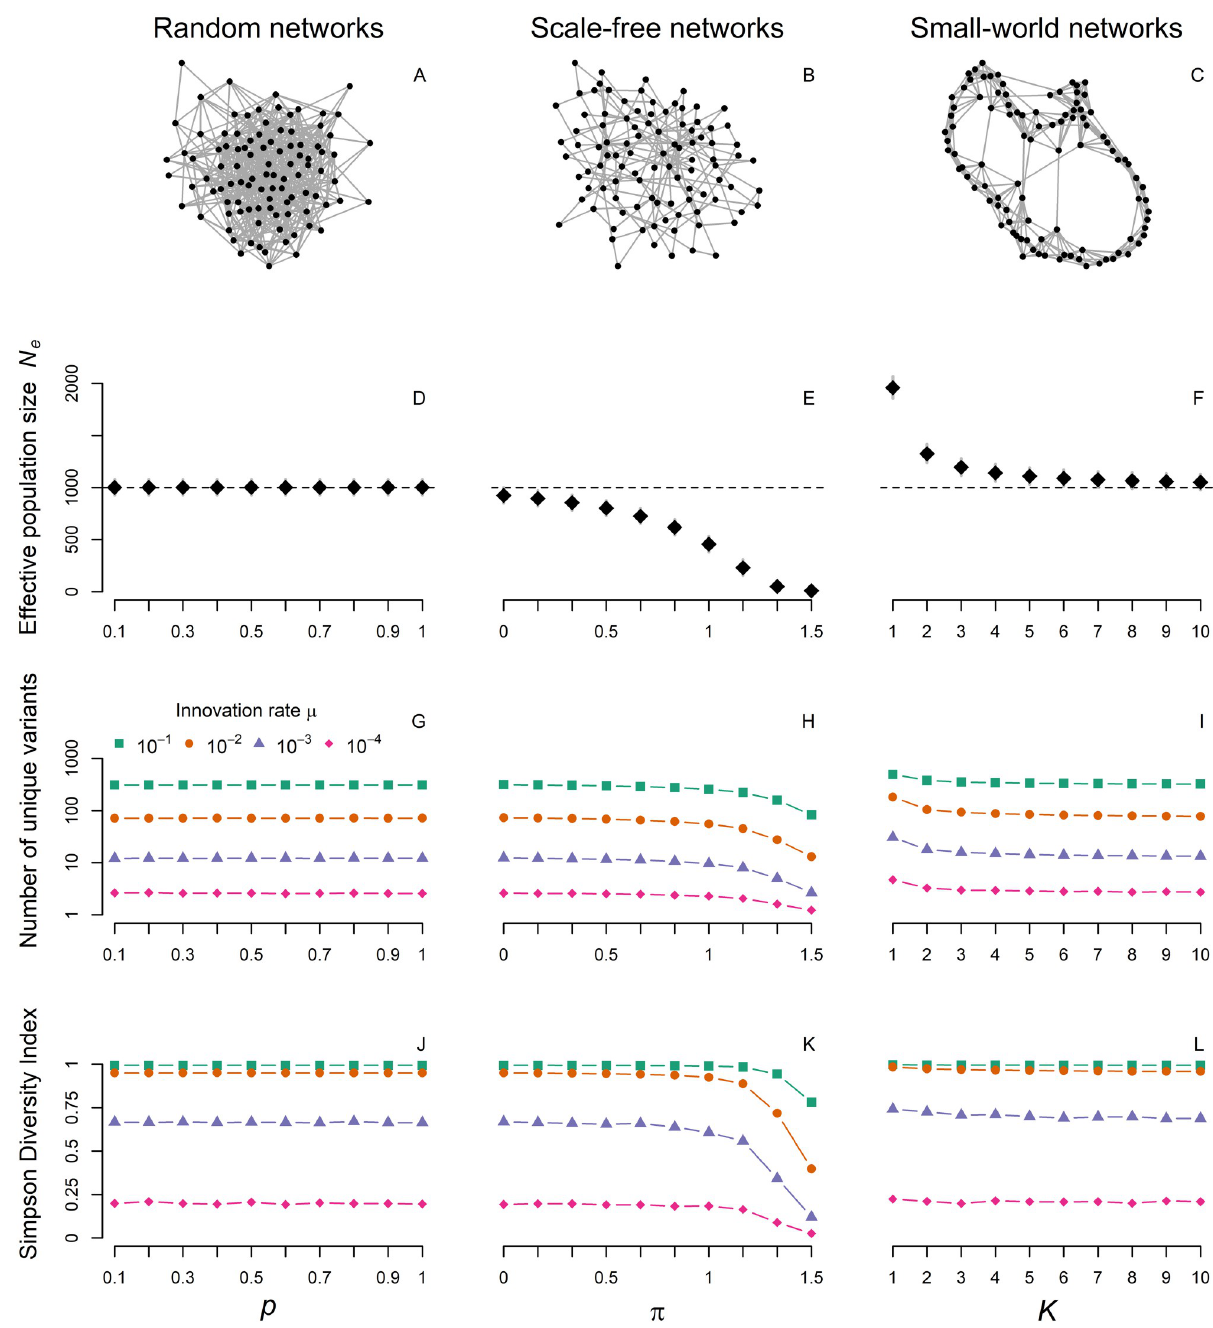
Fig 5. Social network structure. Exemplary networks (A-C), effective population sizes (with 90% PIs; D-F), mean numbers of unique cultural variants (on log scale; G-I) and Simpson diversity indices (J-L) for random (Erd ő s-Re´nyi), scale-free (Baraba´si-Albert) and small-world (Watts-Strogatz) networks. Parameter p gives the probability any two nodes are connected in random networks, π is the power of preferential attachment creating scale- free networks and K represents the number of initial neighbors on each side in small-world networks (with p differences between network types, the ranges of parameter values on the x-axes are not directly comparable. All graphs are created using the igraph R package [43]. Results come from 1000 independent simulations with census population size N = 1000. On the top, only 100 nodes are drawn for ease of illustration with p = 0.1, π = 1 and K =